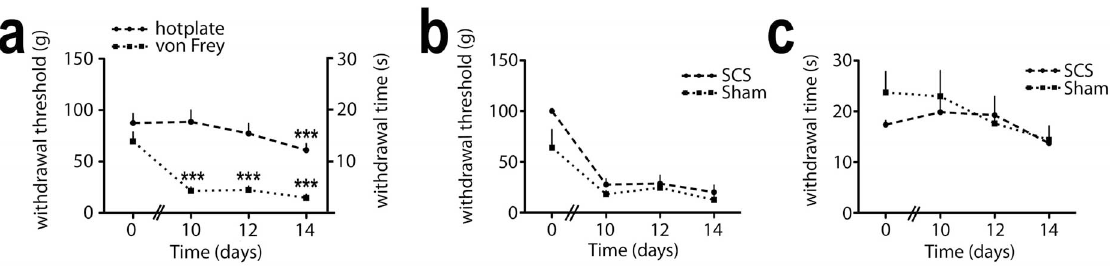
Figure 1. Behavioral data of rats that underwent partial ligation of the proximal sciatic nerve (Seltzer model). (A) Combined results of the von Frey withdrawal thresholds and hotplate latencies, at baseline and 10, 12 and 14 days after nerve ligation, from al 18 rats in the study, demonstrating tactile and thermal hyperalgesia. Error bars indicate SEM. p , 0.01; repeated measures ANOVAs, source of variation timepoint; *** p , 0.01; pairwise comparisons of day 0 versus day 10, 12 and 14, using Bonferroni correction. (B,C) Von Frey withdrawal thresholds (B) and hotplate latencies (C) from 7 neuropathic rats that subsequently underwent SCS and 6 neuropathic rats that subsequently underwent sham stimulation, demonstrating a similar degree of tactile and thermal hyperalgesia in both groups. Error bars indicate SEM. p . 0.06; repeated measures ANOVAs,